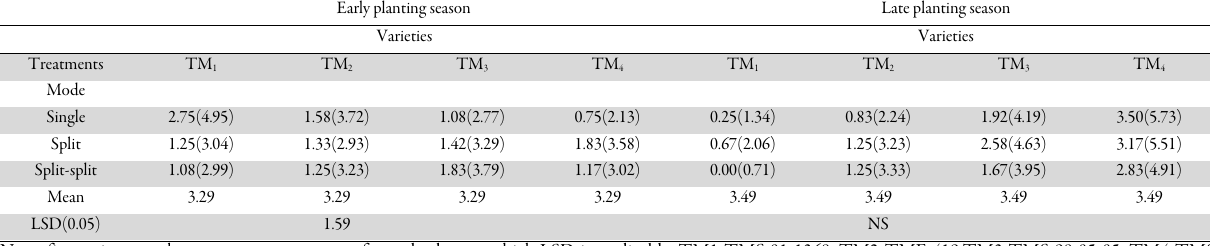
Table 6. Interaction effect of varieties and mode of NPK fertilizer on the incidence of termites on the field at 2MAP Early planting season